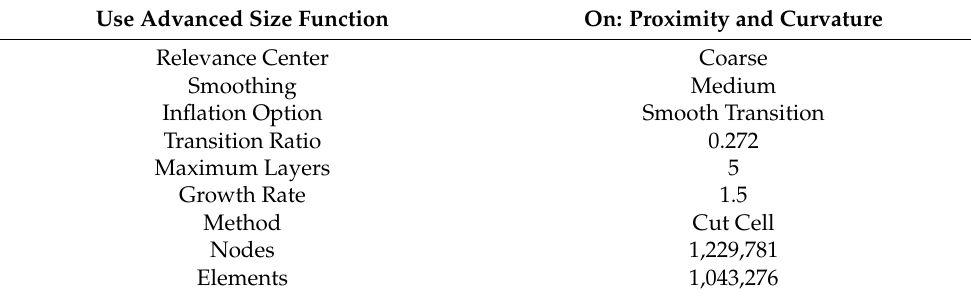
Table 1. Meshing parameters and properties.